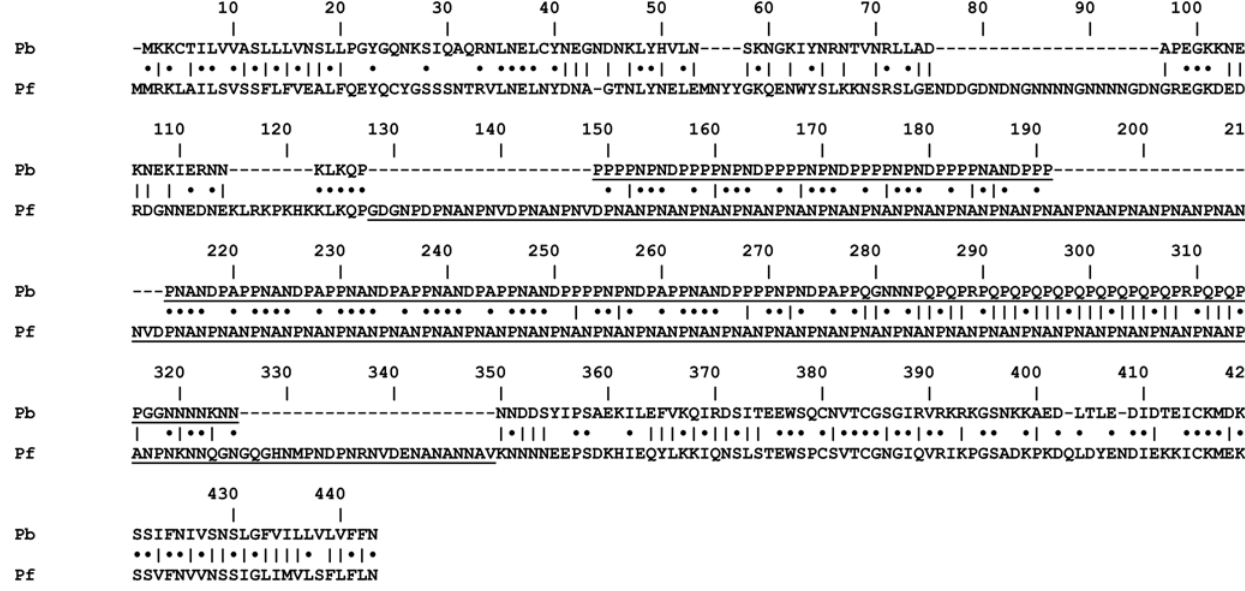
Figure 1. Comparison of the amino acid sequences of the P.berghei ANKA clone cy17 (34) and P.falciparum Welcome strain (35) CSP polypeptides. Black dots represent identical amino acid residues while bars represent amino acid residues with similar characteristics. The repeat regions (including the pre- and post-repeat sequences) are underlined.